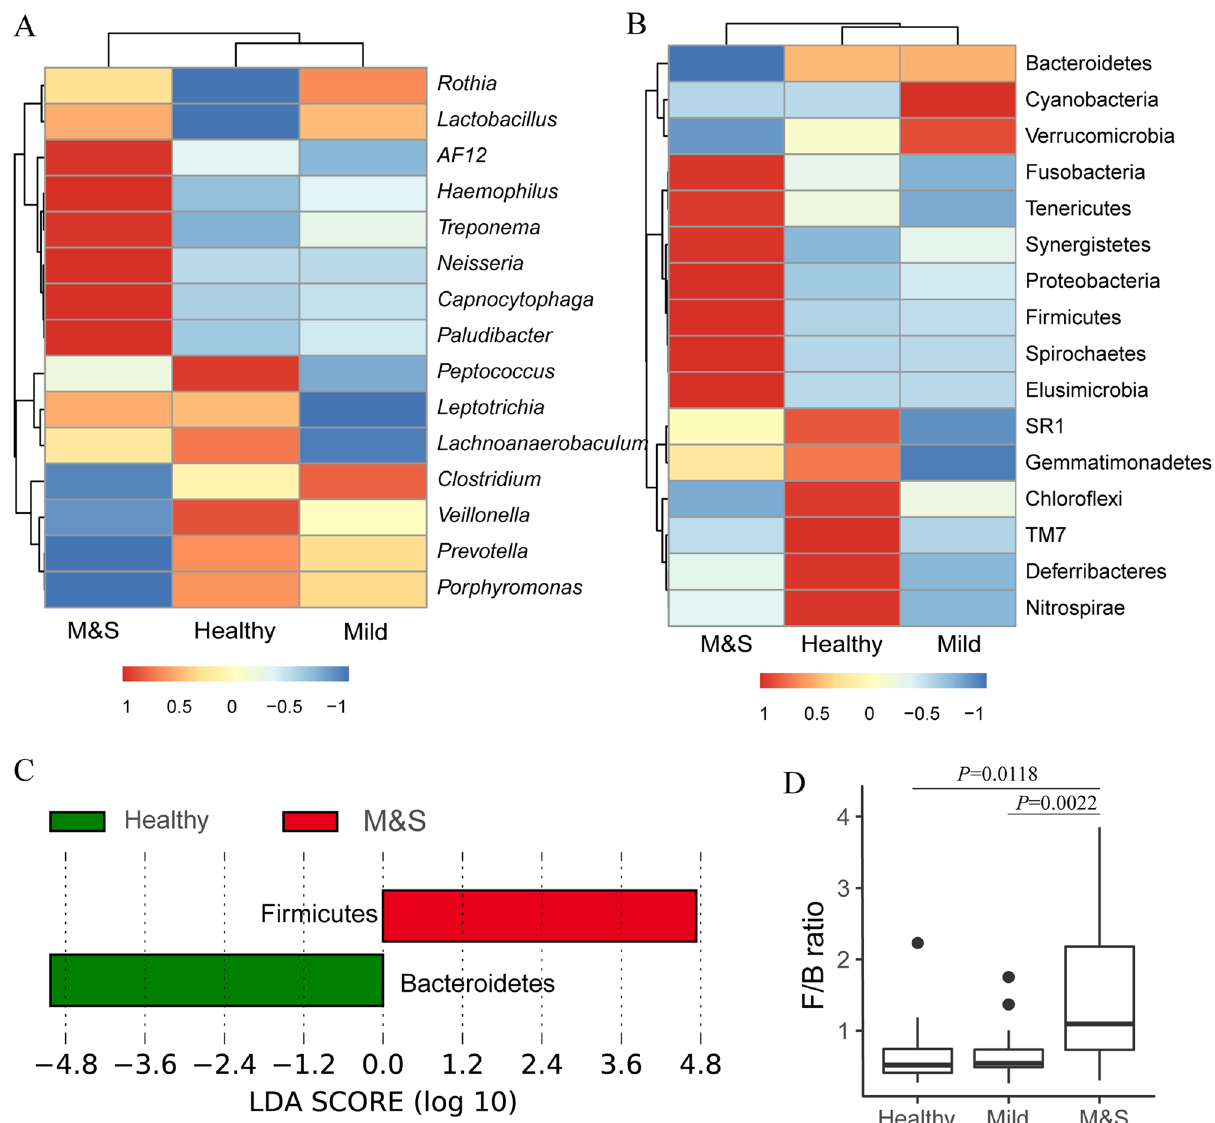
Figure 3. Hierarchically clustered heatmap of taxonomy analysis at the genus ( A ) and phylum ( B ) level using R/pheatmap. ( C ) Significant different taxa at phylum level between Healthy and M&S group based on LEfSe analysis. ( D ) Boxplot for the Firmicutes/Bacteroidetes (F/B) ratio among different groups. The F/B ratio of M&S group was significantly higher than Mild (Wilcoxon Rank Sum Test, P = 0.002). There was no statistical difference between Healthy and M&S group (Wilcoxon Rank Sum Test, P =